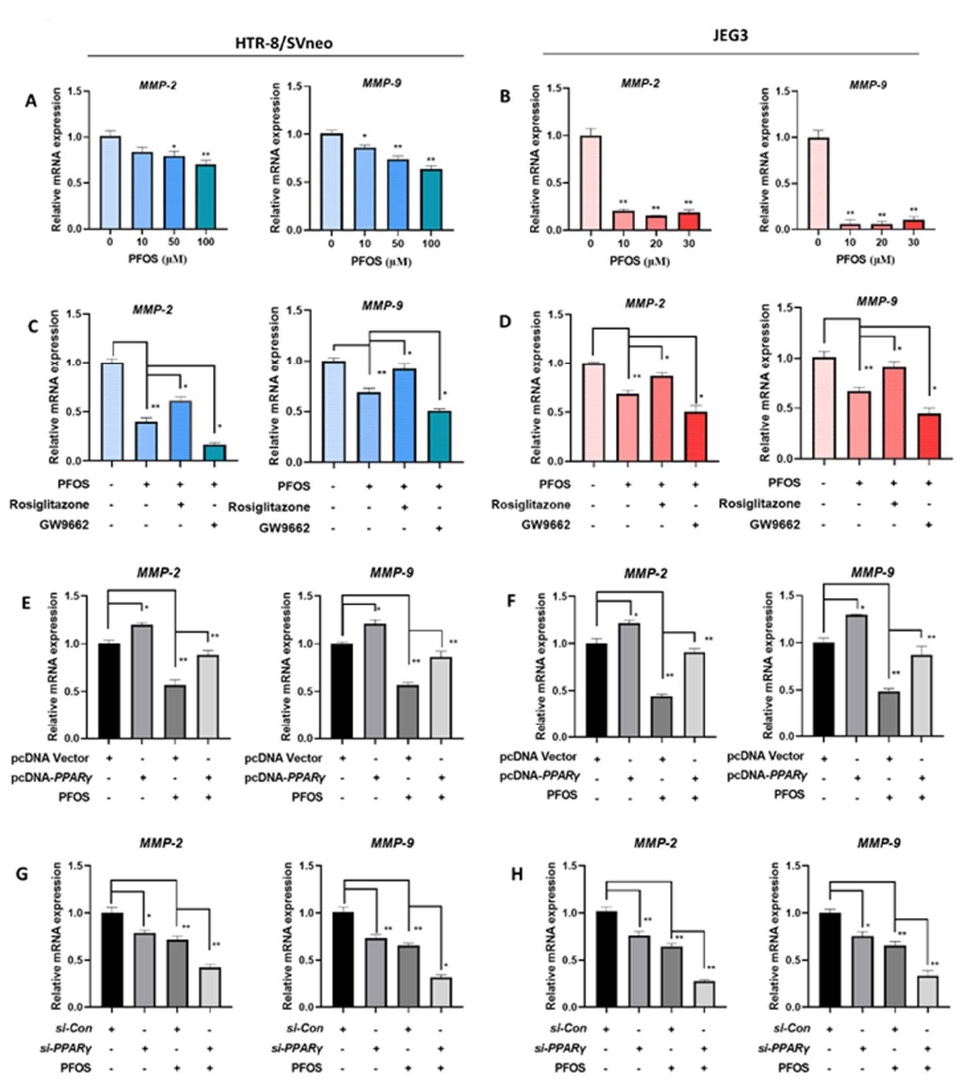
Figure 5. PFOS alters mRNA level of PPAR γ target genes associated with migration. The mRNA expression was analyzed by RT-PCR in HTR-8/SVneoand JEG-3 cells were exposed to PFOS for 24 h ( A , B ), in the absence or presence of rosiglitazone and GW9662 ( C , D ), with PPAR γ overexpression ( E , F ) and knocking down ( G , H ) in HTR-8/SVneo and JEG-3 cells. The data are shown as the means ± S.E.M. * p < 0.05; ** p < 0.01; compared with the indicated group, n = 3.